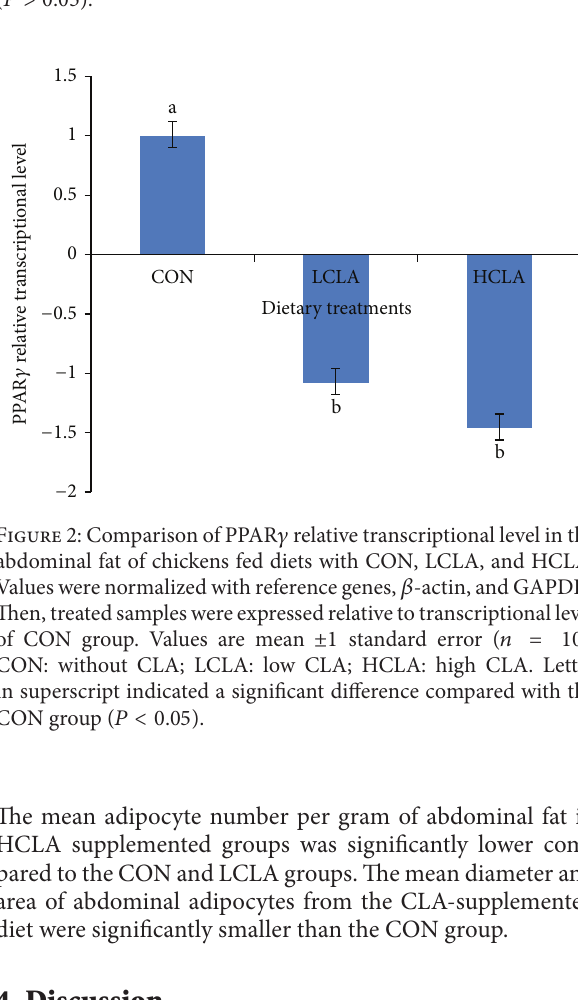
Figure 3: Comparison of aP2 relative transcriptional level in the abdominal fat of chickens fed diets with CON, LCLA, and HCLA. Values were normalized with reference genes, 𝛽 -actin, and GAPDH. Then, treated samples were expressed relative to transcriptional level of CON group. Values are mean ±1 standard error ( 𝑛 = 10 ). CON: without CLA; LCLA: low CLA; HCLA: high CLA. Letter in superscript indicated a significant difference compared with the CON group ( 𝑃 < 0.05 ).